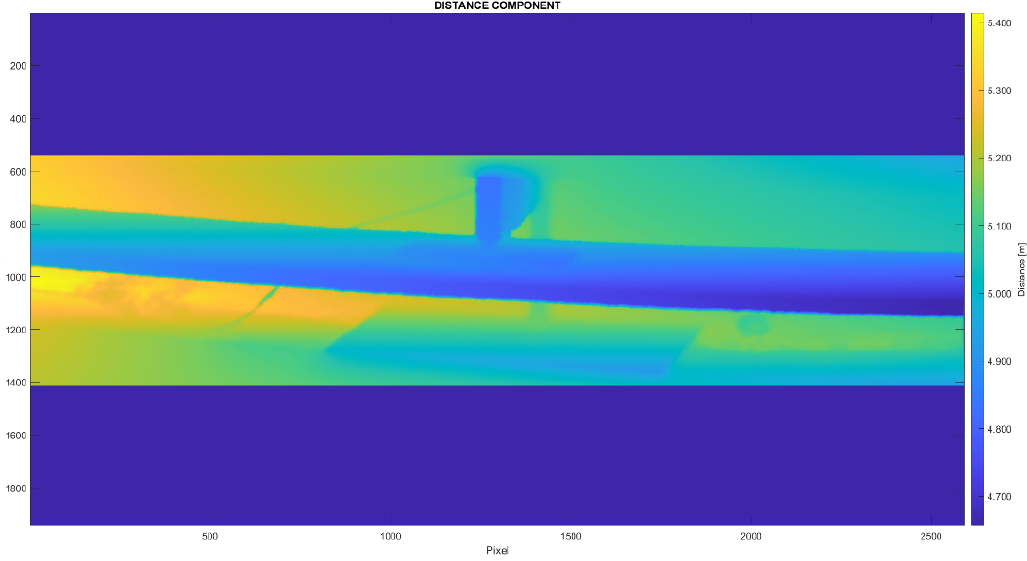
Figure 10. Distance (D) channel of an RGB+D image within an ROI (Source: Own compilation).